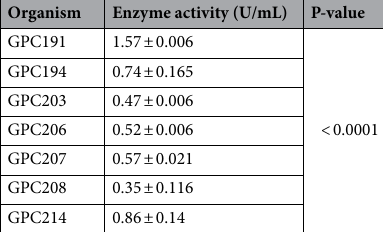
Table 2. Comparison of enzyme activity over isolates.